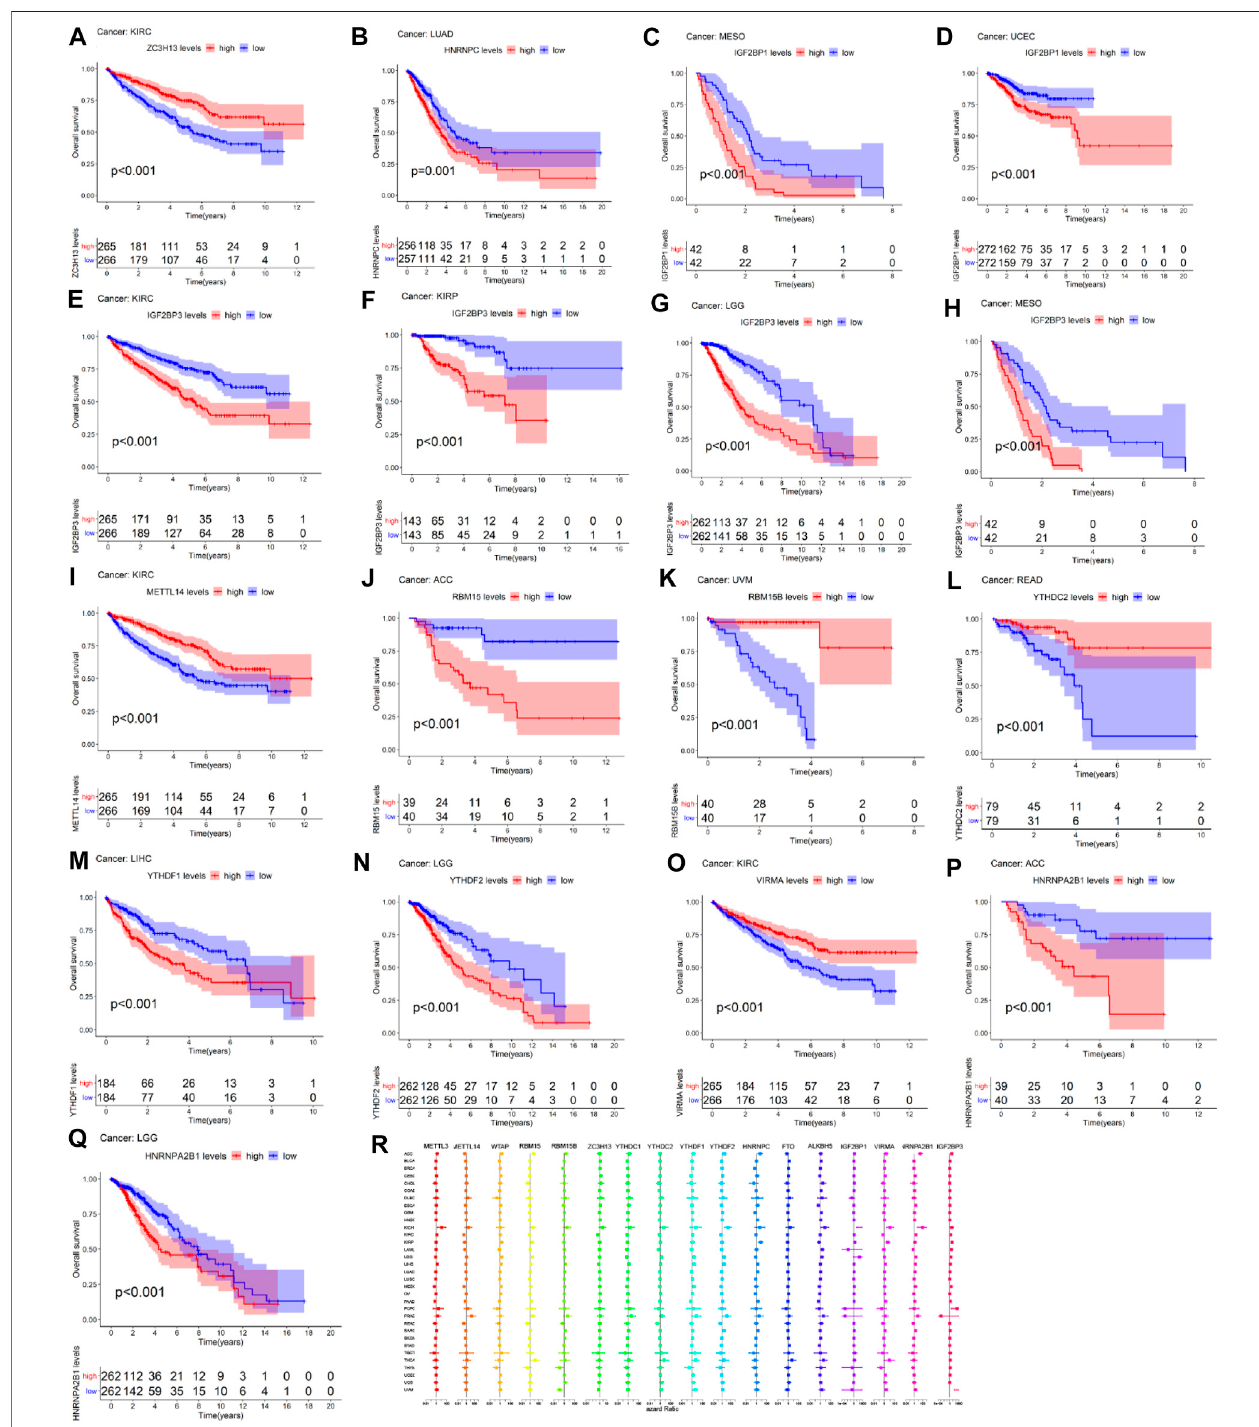
FIGURE 4 | Survival analysis of m6A-related regulators across multiple cancer types. The red line in the photos indicates high expression and the blue line in the photos indicates low expression. (R) The forest map of hazard ratio of 17 m6A-related genes across 33 TCGA cancer types.